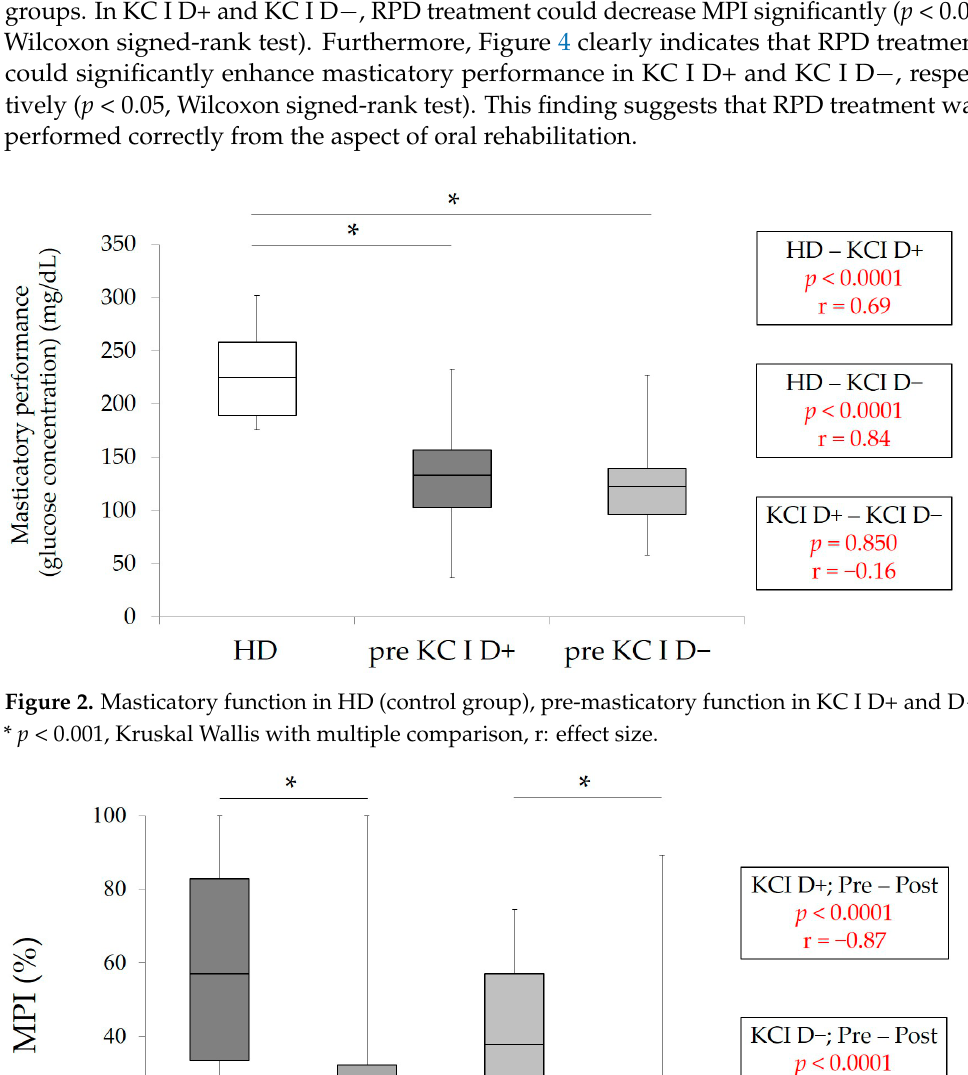
Figure 1. MPI in HD (control group), pre-MPI in KC I D+ and D − . * p < 0.05, Kruskal–Wallis with multiple comparison, r: effect size.